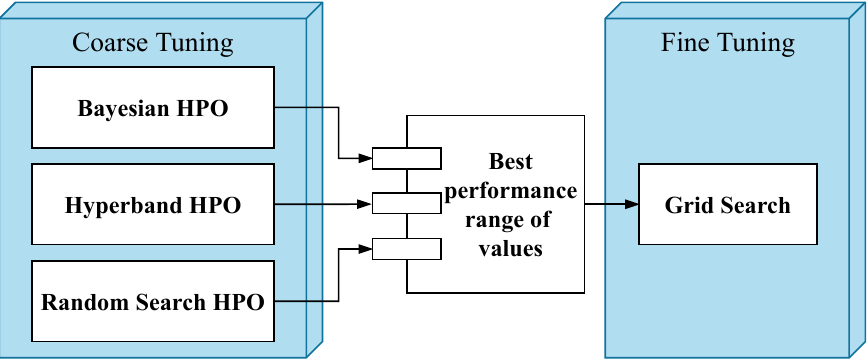
Figure 11. Two-stage HPO process. Both coarse and fine-tuning processes are used together for increased control in determining the optimum values of the